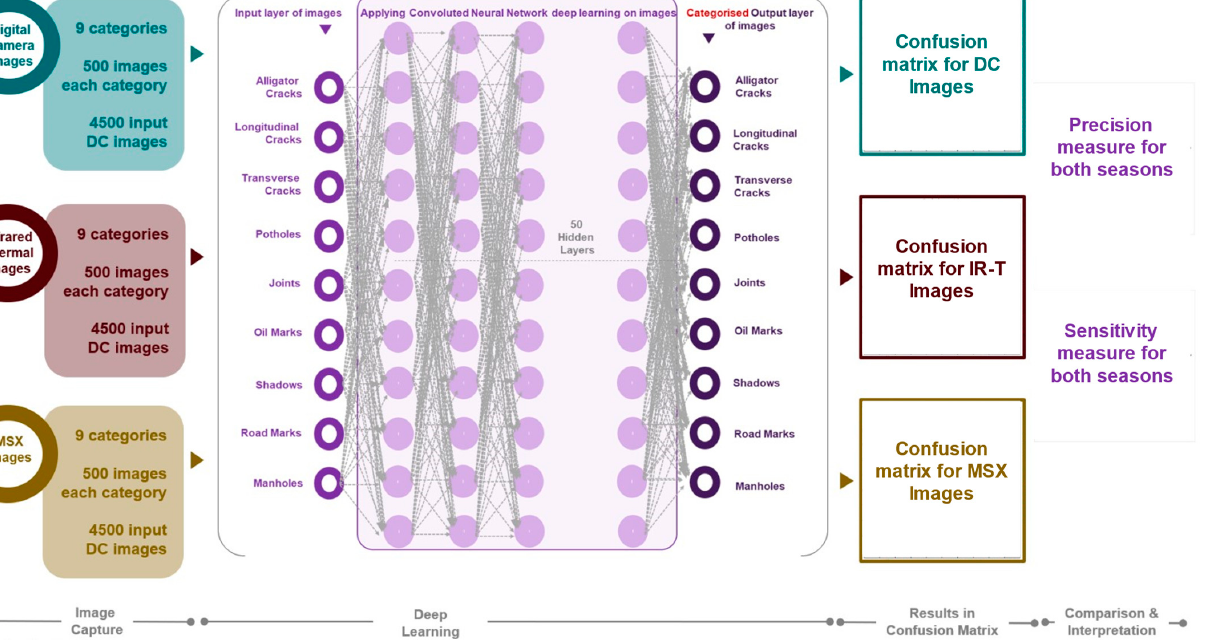
Figure 2. Location of data collection. Nine pavement features were considered, namely (1) transverse cracks, (2) longitudinal cracks, (3) alligator cracks, (4) joints or patches, (5) potholes, (6) manholes, (7) shadows, (8) road markings and (9) oil stains. The FLIR ONE camera connected to a cell phone was used for data capture, wherein FLIR ONE’s in-built application displays real-time thermal infrared images and saves both RGB and thermal images in one image by default. The images were then extracted through the MATLAB API interface provided